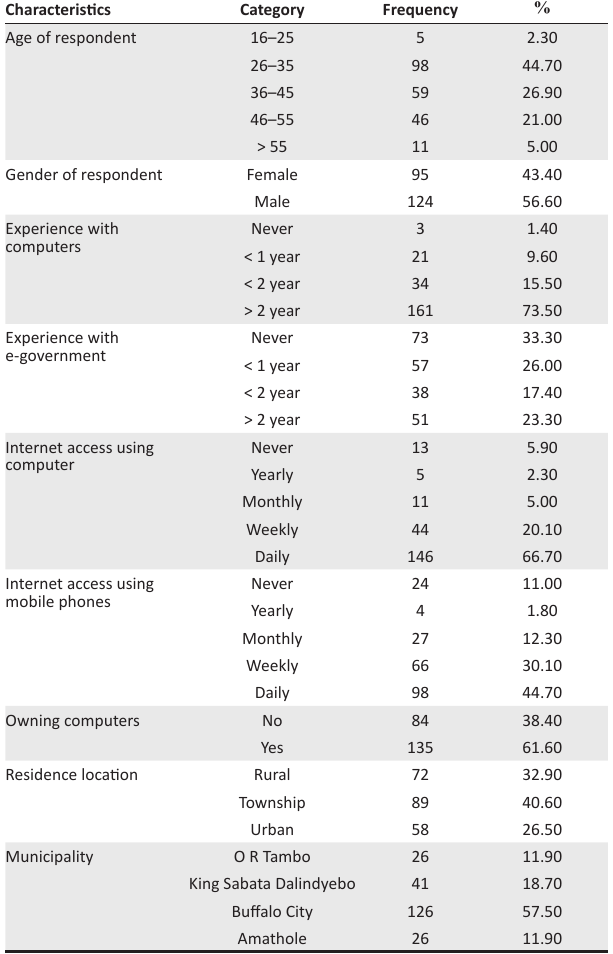
TABLE 1: Profile of respondents ( N = 219).